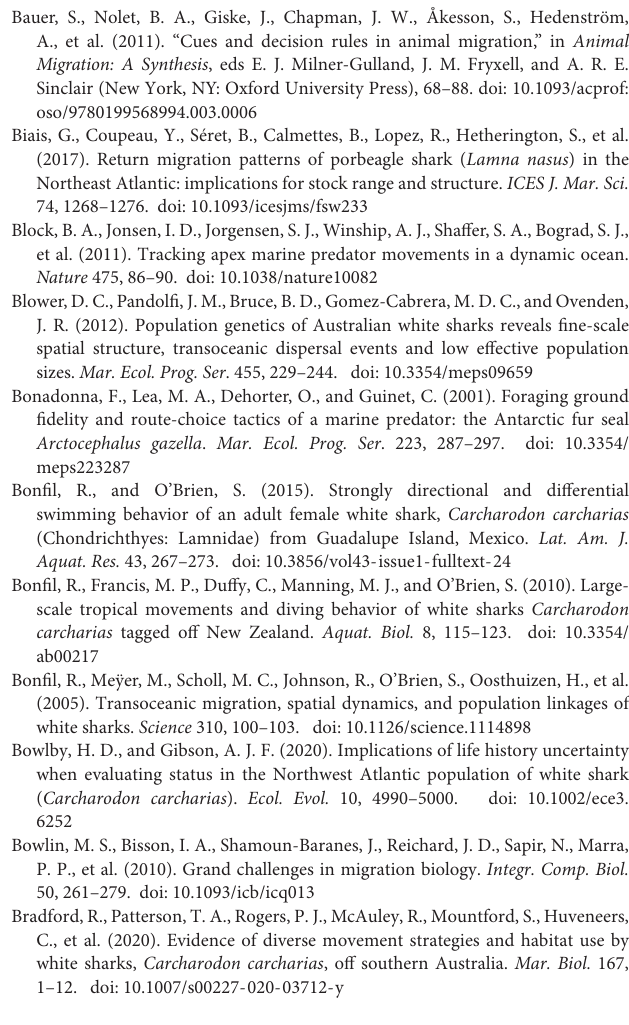
Supplementary Figure 6 | Week-long depth profile from recovered PSAT of white shark NS2018-06 demonstrating contrasting vertical movement between resident and transient phases. (A) High resolution depth data from October 29 to November 5. Mean daily distance traveled for the resident (red) and transient (green) phases is shown as a colored trace (right axis). (B) Inset map of the mid Atlantic coast showing the most probable track (MPT) for this period. (C) Time-at-depth for the resident phase. (D) Time-at-depth for the transient phase. Supplementary Figure 7 | Daily regularized locations classified as resident behavior ( b > 1.75) for sharks captured in Massachusetts and Nova Scotia showing fidelity to summer/early autumn residency areas. Supplementary Figure 8 | Migration pathways from regularized daily locations for a 3.8 m TL adult male white shark (LC2017-01) (A) over a 2-year cycle (2017–2018) demonstrating both on-shelf and off-shelf migrations. Tracks are color-coded by year and season. Northern migrations represented by red hues, southern migrations by green, and residency locations by blue. This shark migrated on-shelf during both northward migrations but migrated off-shelf during one of two southward migrations during its 2-year tracking period. Raw SPOT and acoustic locations for a 3.7 m TL subadult female (ACK2016-02) in the region around Massachusetts over a 5-year period (B) and 3.9 m TL adult male (NS2018-03) in the region around Nova Scotia over a 3-year period (C) showing fine-scale fidelity to specific areas within the summer/autumn foraging areas. In panels (B,C) , common months share symbols and common years share